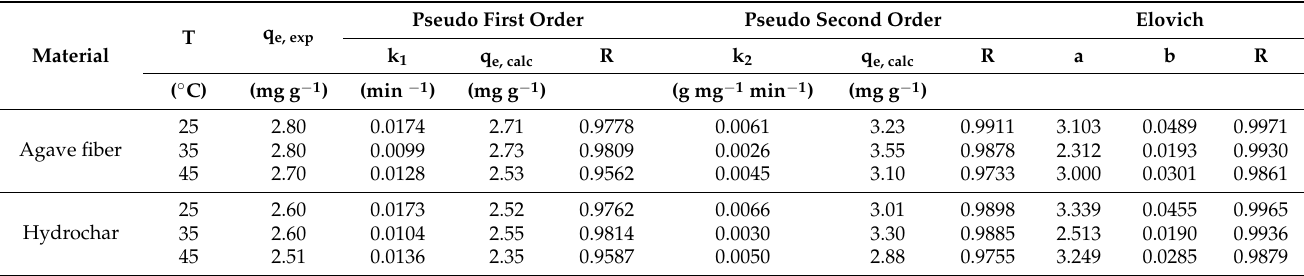
Table 3. Kinetic constants of the mathematical models proposed to describe the adsorption process of DB-86 on the adsorbent prepared from agave bagasse fibers.